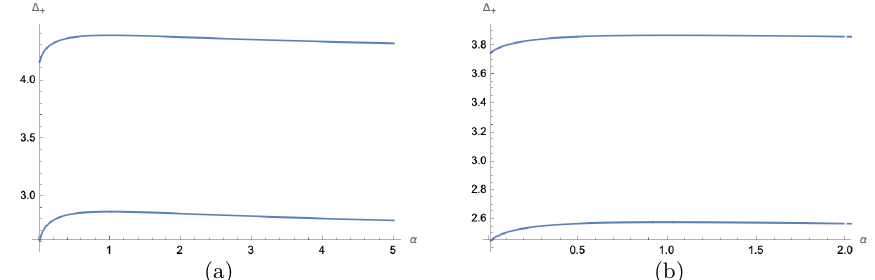
Figure 6. (a) Conformal dimension of operator dual to scalar fluctuations around the N = (1 , 1) vacuum for truncation 2, (b) same for truncation